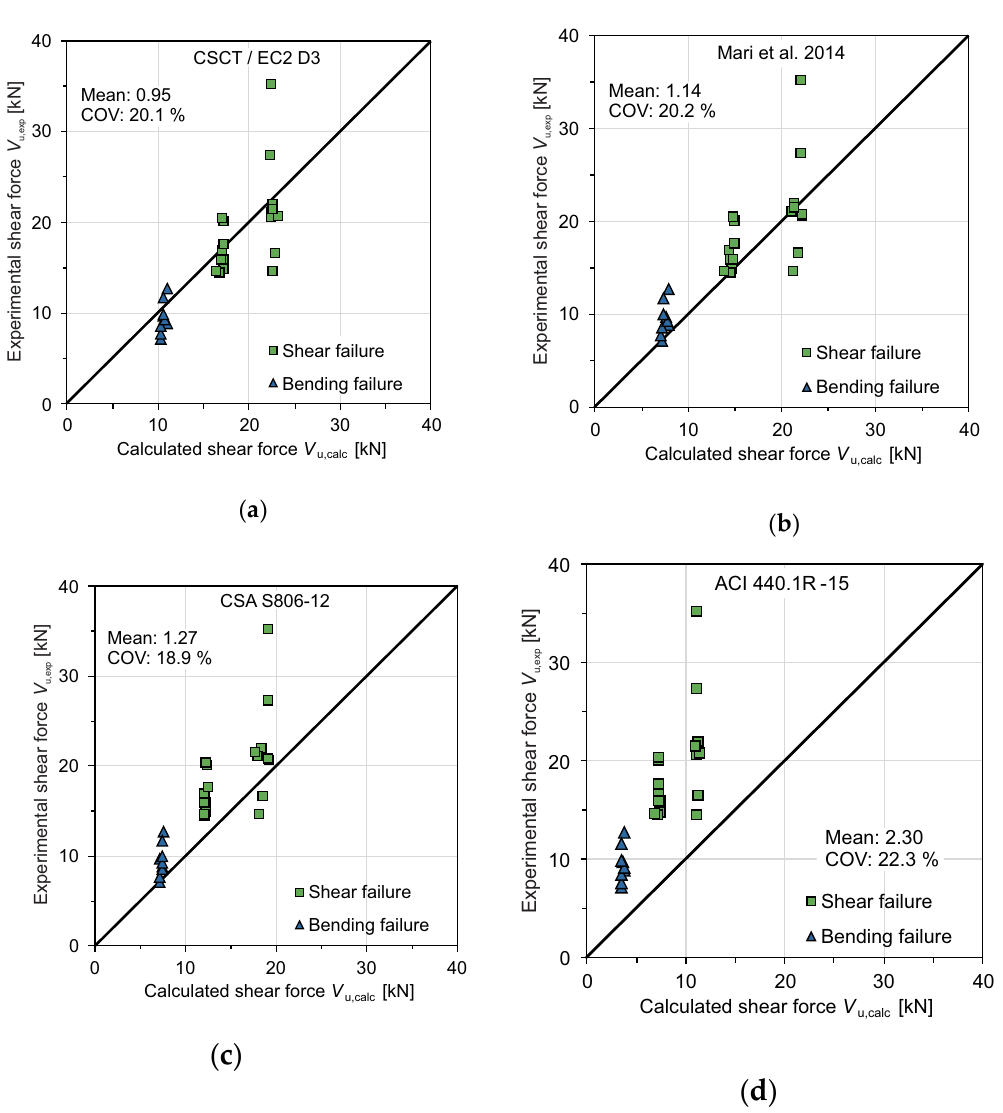
Figure 9. Comparison of experimental results to predicted shear force: ( a ) Critical shear crack theory (CSCT) [83–85]; ( b ) Model by Mari et al. [46]; ( c ) Design formula from CSA S8-06-12 [53]; ( d ) Design formula from ACI 440.1R-15 [54].